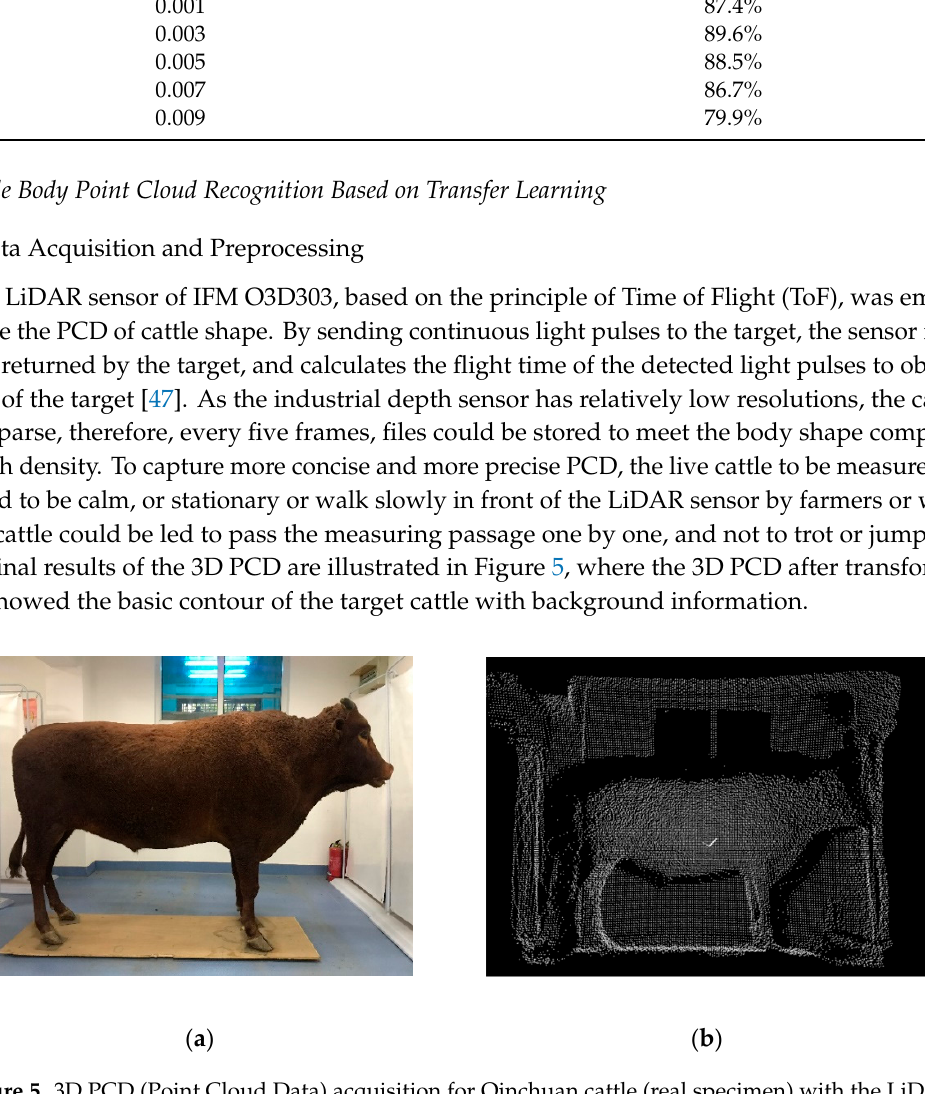
Figure 6. Filtering results with multiple filters. ( a ) Original PCD; ( b ) Results with three filters where most noises and outliers were well removed.